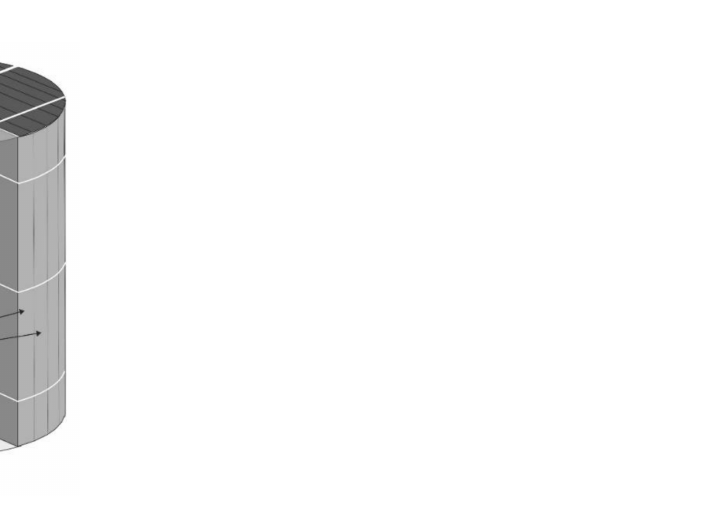
Figure 3. A simplified scheme of the studied fractured coal samples, the direction of gas filtra- tion in laboratory tests, and the location of surfaces along which the coal microstructural analysis was performed. α —plane perpendicular to the face and butt cleat direction, β —plane of the core end surface. Table 3. The main characteristics of the Mineral C7 analyzer [32]. Range of Measurement of Linear Dimensions, µ m From 0.5 to 2000 The relative value of the standard deviation of the random component of the error (considering the contribution of the analyzer software), %: -with an increase up to × 500 inclusive 0.2 -with an increase over × 500 0.4 Relative error of measurement (considering the contribution of the analyzer software), %: -with an increase up to × 500 inclusive +/ − 0.25 -with an increase over × 500 +/ −